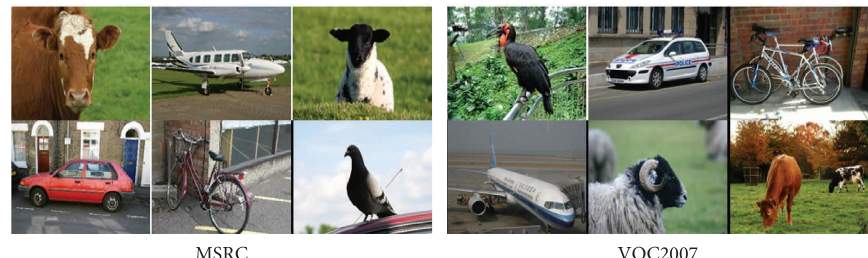
Figure 4: Images from MSRC and VOC2007